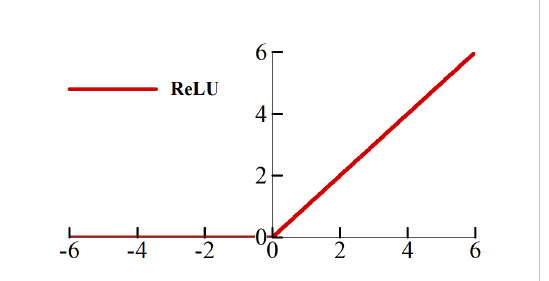
Figure 7. Curve of ReLU activation